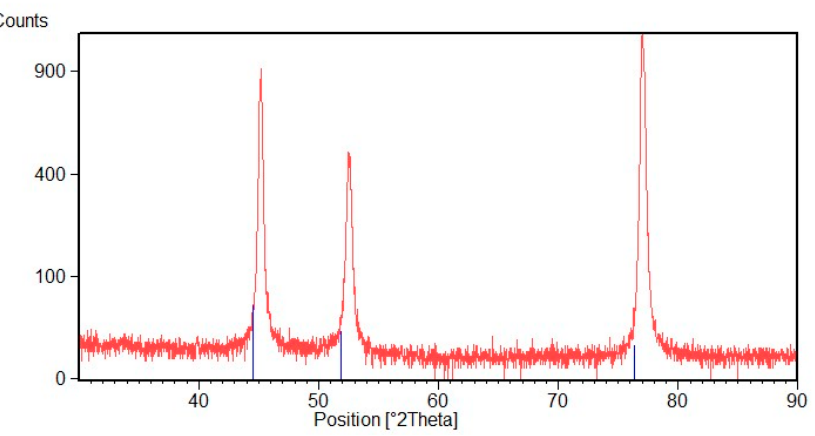
Figure 9. XRD diffraction pattern of Ni Figure 9. XRD di ff raction pa tt ern of Ni deposit.